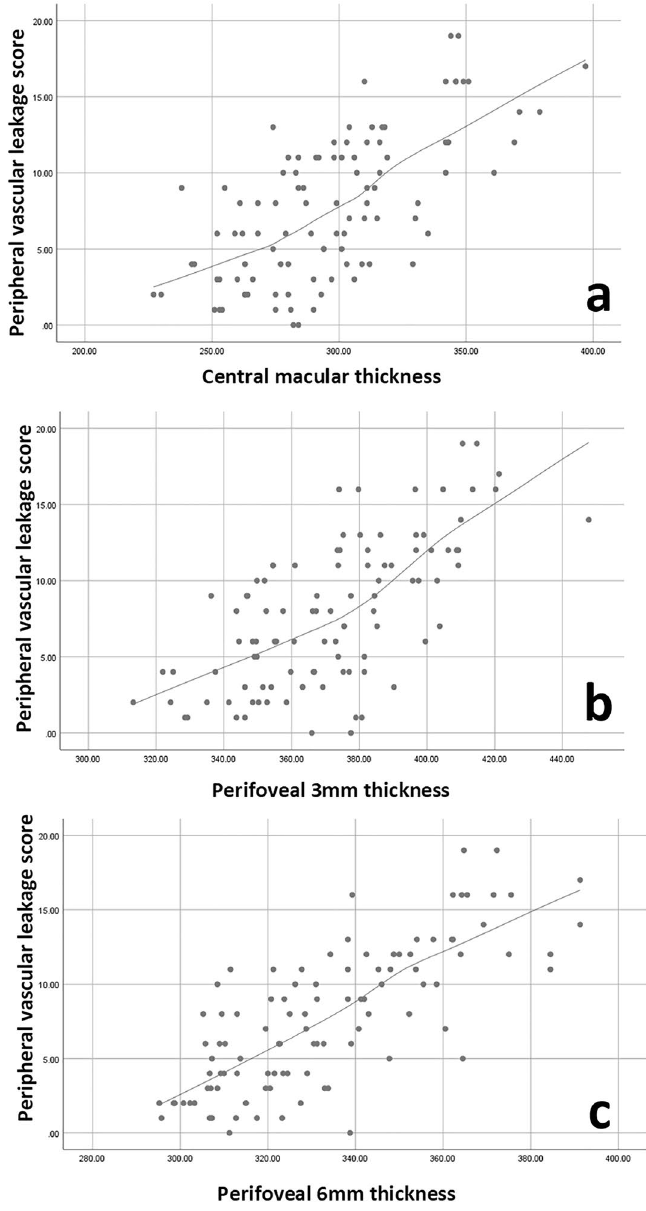
Figure 2. Scatterplot showing the correlation between peripheral vascular leakage score and CMT ( a ) as well as perifoveal 3 mm ( b ) and 6 mm ( c )